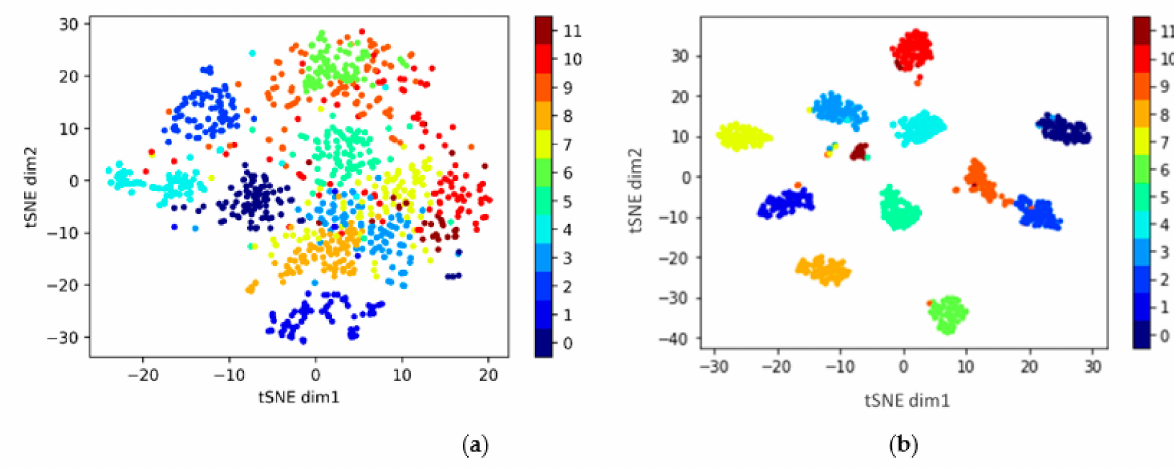
(cid:8) (cid:9) → A D , P D , N D M D experiment: ( a ) features without domain adaptation,